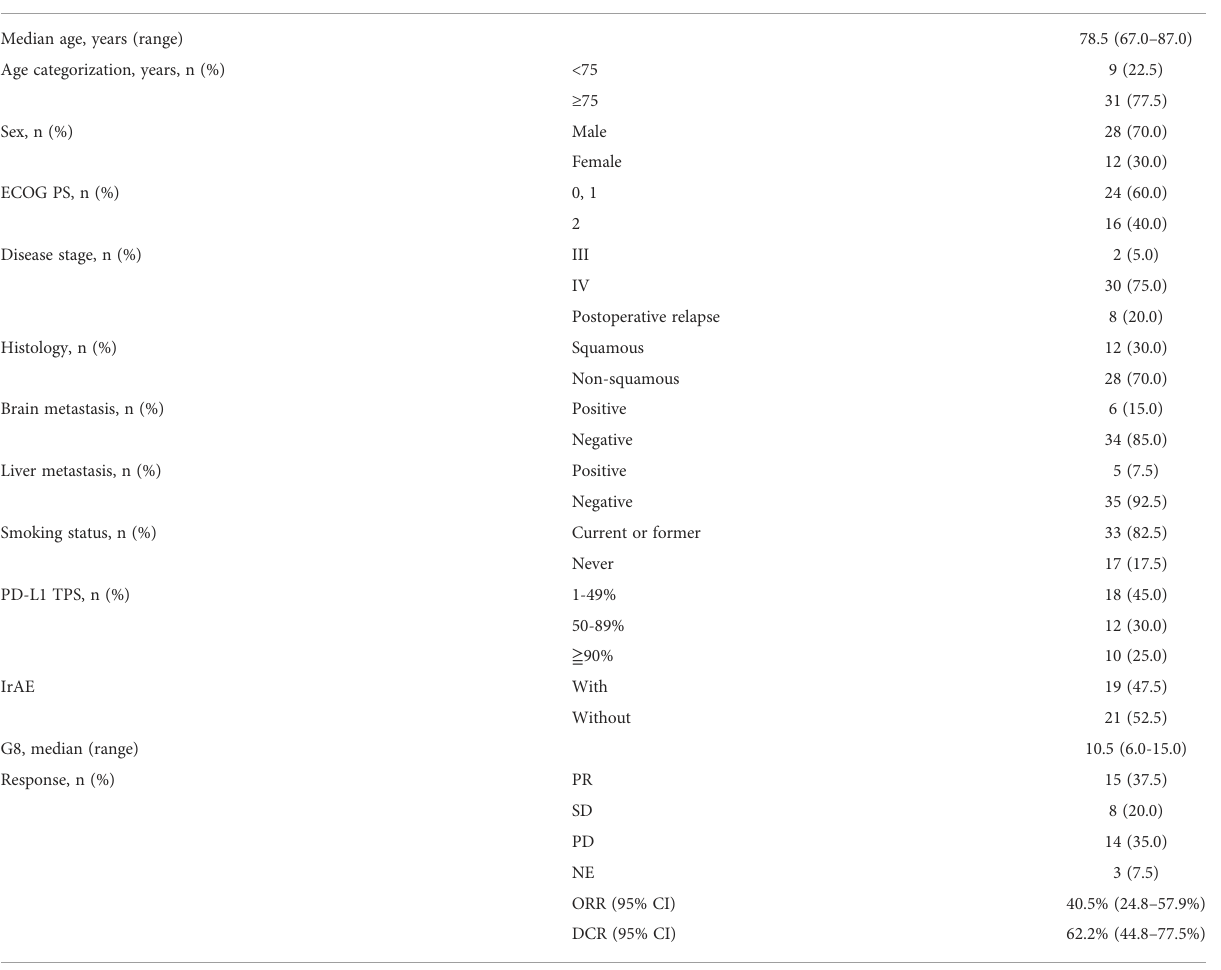
TABLE 1 Patients ’